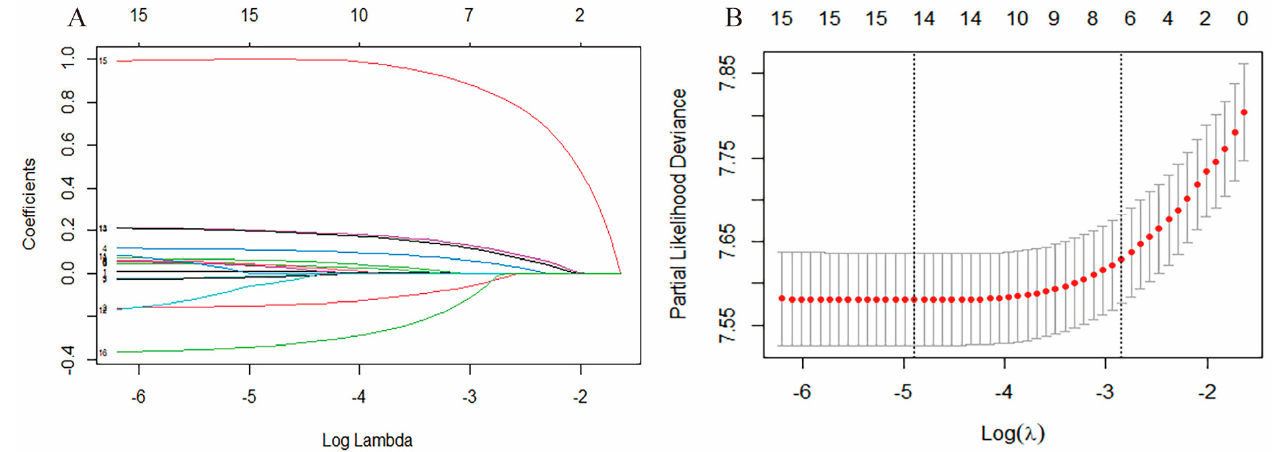
Figure 1. ( A ) LASSO coefficient profiles of the candidate predictors. ( B ) Selection of the optimal penalization coefficient in the LASSO regression.